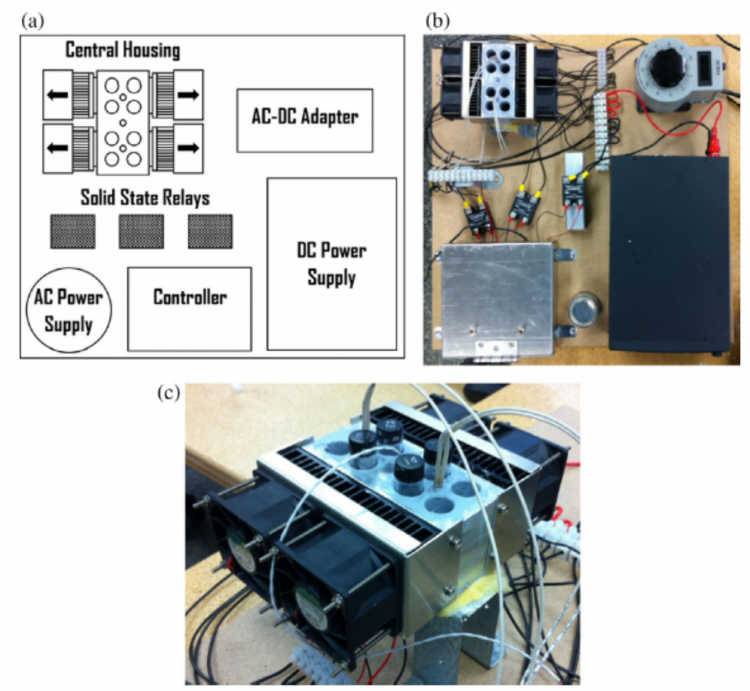
Figure 11. ( a ) Schematic diagram showing the various components of the thermal cycler general assembly, ( b ) photograph of the actual experimental setup, and ( c ) photograph of the housing unit with the heating and cooling elements and vials containing PCM (reproduced with permission from [22], Elsevier,